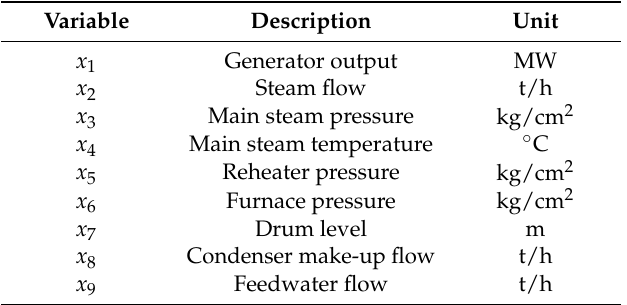
Table 1. Summary of monitored variables for target drum-type steam